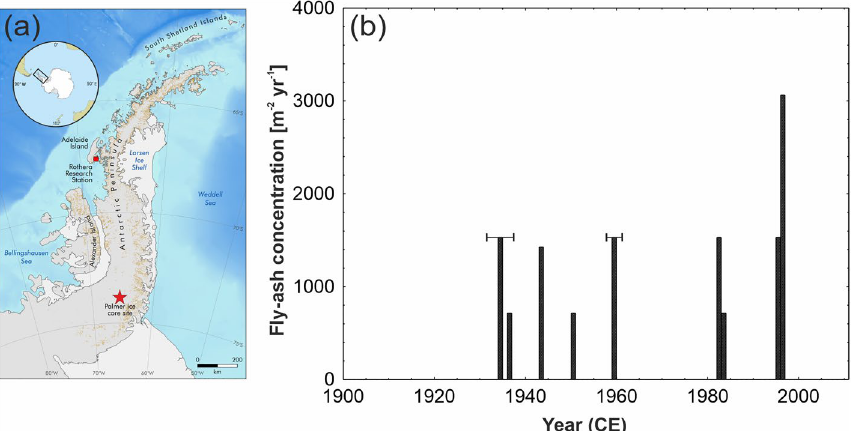
Figure 1. SCP deposition in the Palmer ice core. ( a ) Map of the Antarctic Peninsula, with insert of Southern Hemisphere, showing the location of the Palmer ice core (red star). ( b ) Fly-ash concentration (m −2 year −1 ) (1900–2011 CE) with age uncertainty shown by error bars. Map produced using the Antarctic Digital Database, using data made available under the Creative Commons Attribution 4.0 International (CC BY 4.0) licence.